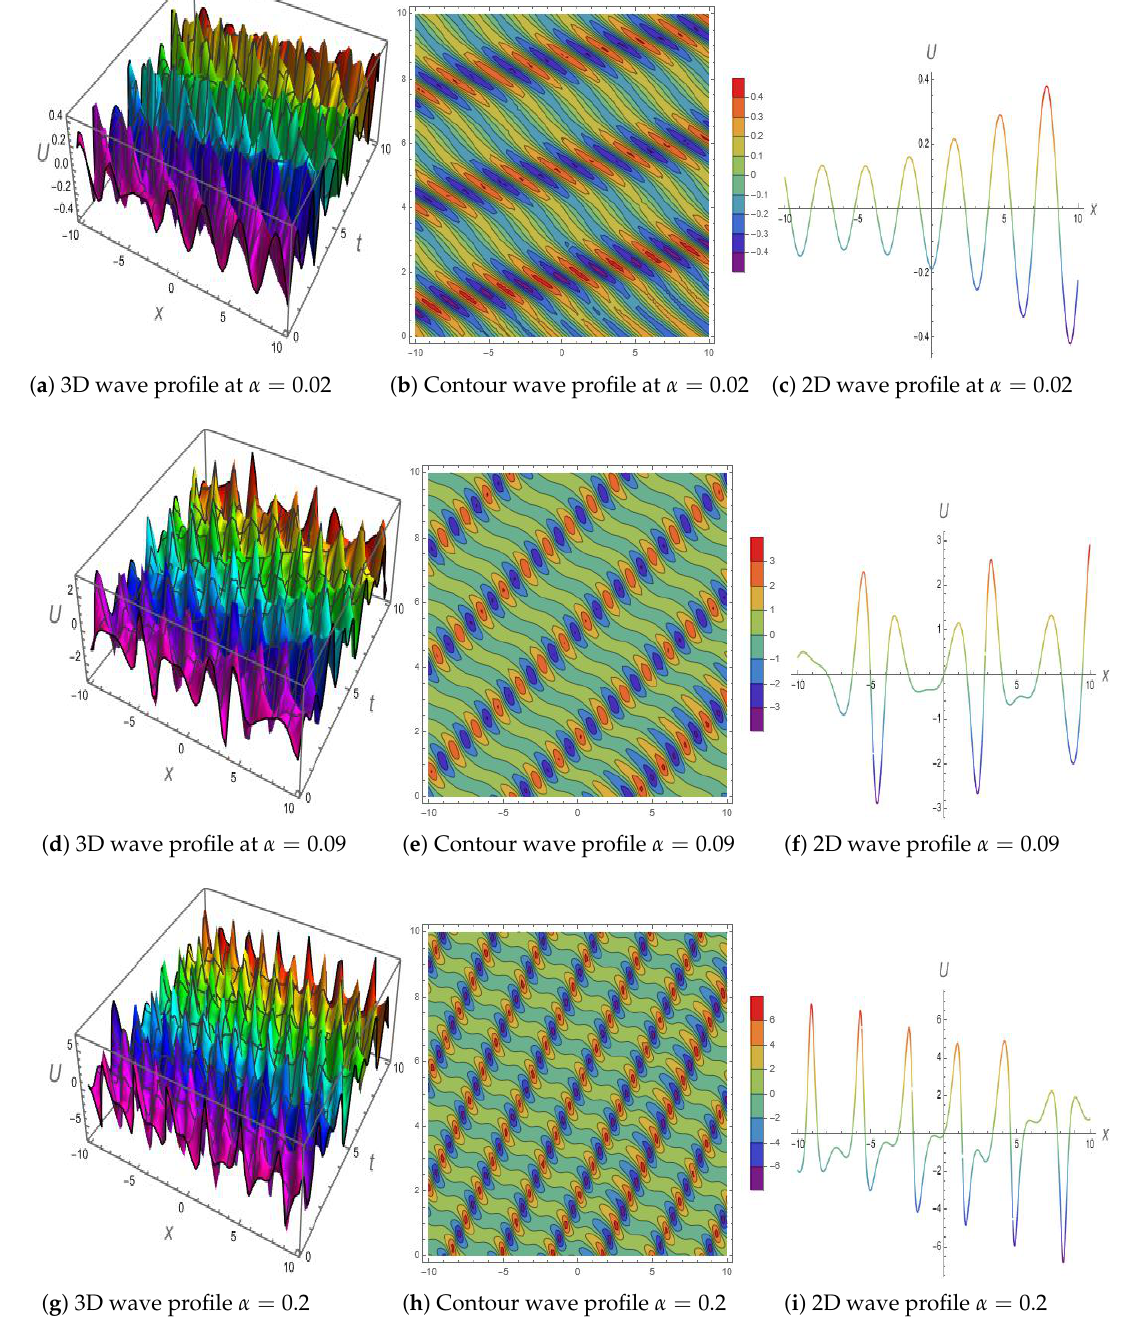
Figure 1. 3D, Contour and 2D impact of wave number α on the Real part of solution U 3